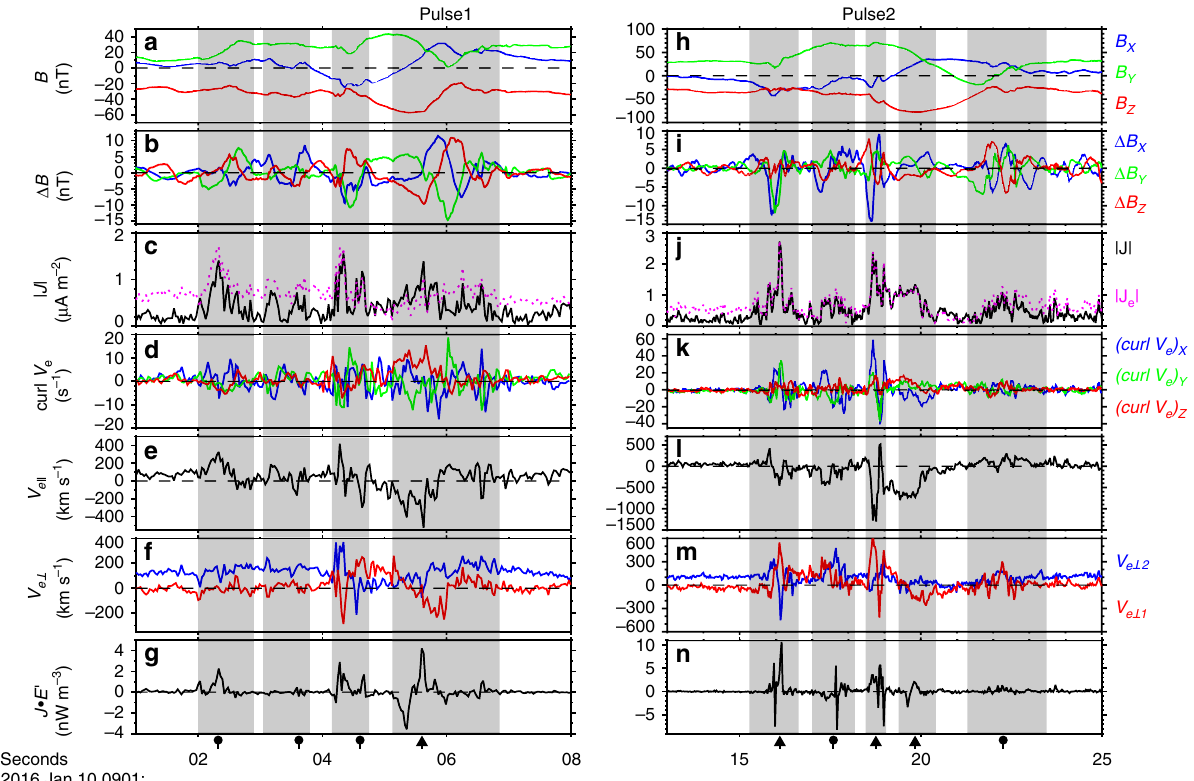
Fig. 2 Enlarged view of two fl ux ropes. The two ropes correspond to the left and right columns. The vertical shadows mark the varied magnetic fi eld pulses. Different black arrows below the vertical shadows represent two kinds of varied magnetic fi eld pulses with different signatures. a Three components of the magnetic fi eld in GSM coordinates. b The perturbation in magnetic fi eld B with the 1-s average data removed. c The total (black trace) and electron (pink trace) current density intensity. The total current density intensity j J j ¼ eN j V i (cid:2) V e j , the electron current density intensity j J j ¼ eN j (cid:2) V j , where e is the elementary charge, N is the electron number density, and V V e e i and e are the ion and electron velocity. d The curl of electron velocity. e The parallel electron velocity. f The two perpendicular components of the electron velocity, ⊥ 1 along ( v e × b ) and ⊥ 2 along b × ( v e × b ), where b and v e are unit vectors of the background magnetic fi eld and the electron fl ow, respectively, calculated with the background average value outside the fl ux ropes. Here, b = (0.188, 0.679, − 0.709) and v e = ( − 0.500, − 0.124, − 0.857) determined from interval 09:01:10.0 – 09:01:11.5 UT. g J • E ′ = J • ( E + V e × B ). h – n The data of the rope FR2 are displayed in the same form and b = (0.176, 0.657, − 0.733) and v e = ( − 0.502, − 0.334, − 0.798) for FR2 determined